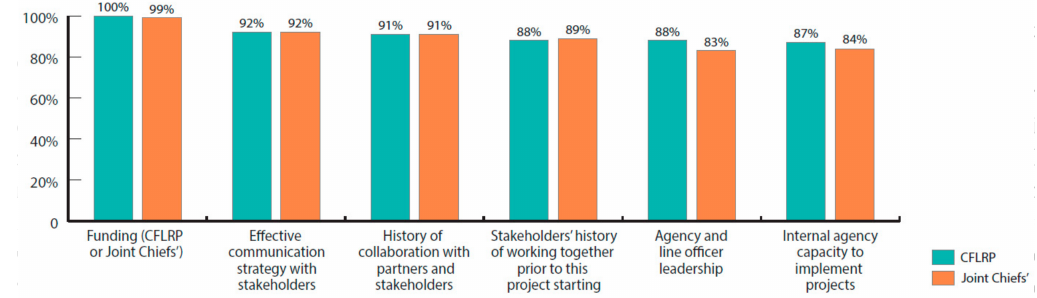
Figure 5. Percent of respondents who indicated that various internal and external factors were a major or somewhat major contribution to project success. Note: The items in the figures were the ones selected by the most participants and do not include all items included in the respective sections of the